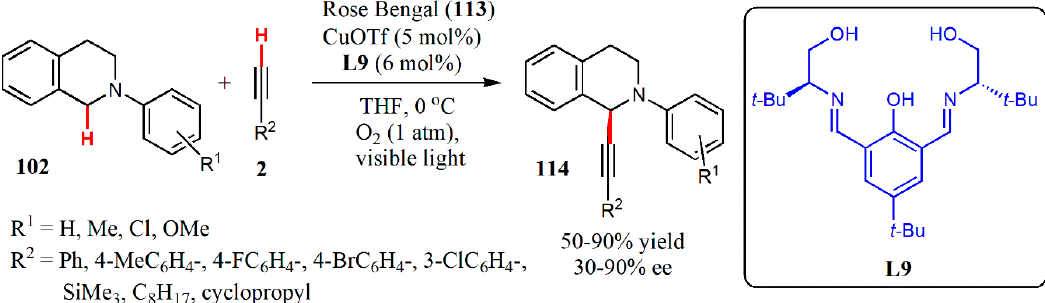
Figure 35. Cooperative organo-photocatalysis in the CDC of THIQs and alkynes.